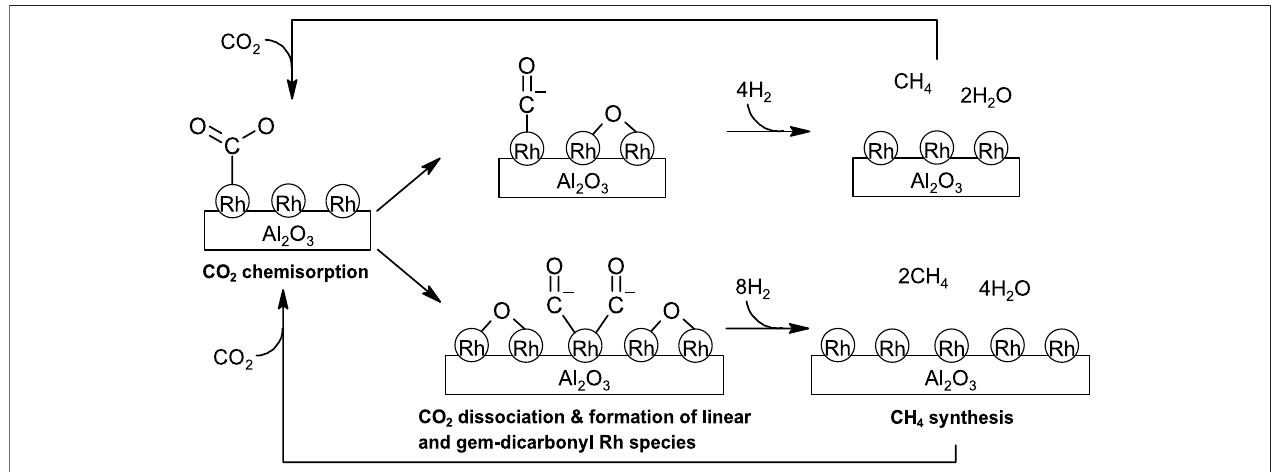
FIGURE 2 | Scheme of reaction mechanisms of Rh/Al 2 O 3 catalyst in CO 2 methanation (Jacquemin et al., 2010; Beuls et al., 2012; Kim et al., 2020)